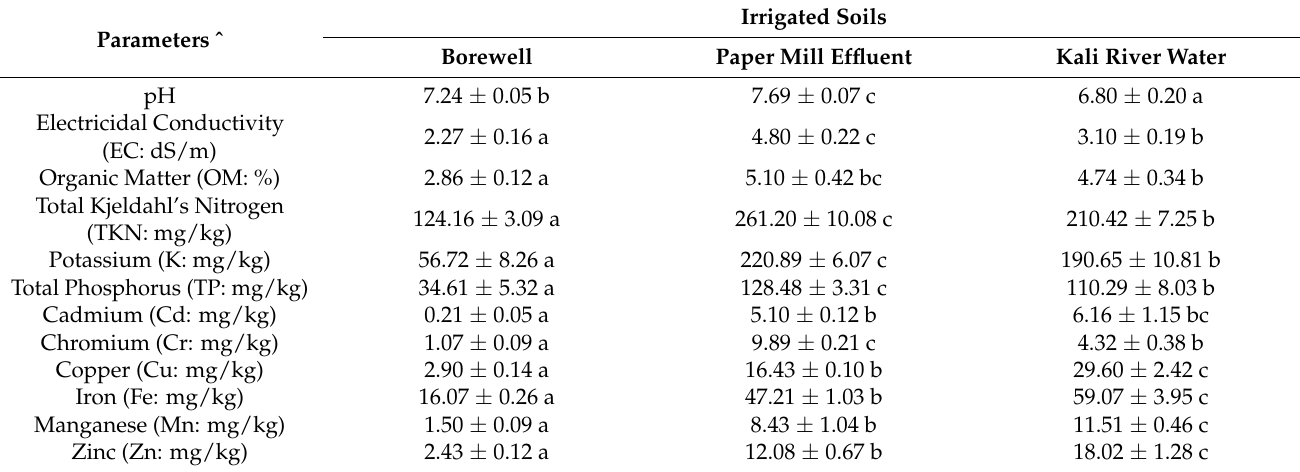
Table 2. Average characteristics of soils irrigated with borewell, paper mill effluent, and Kali River water in the study